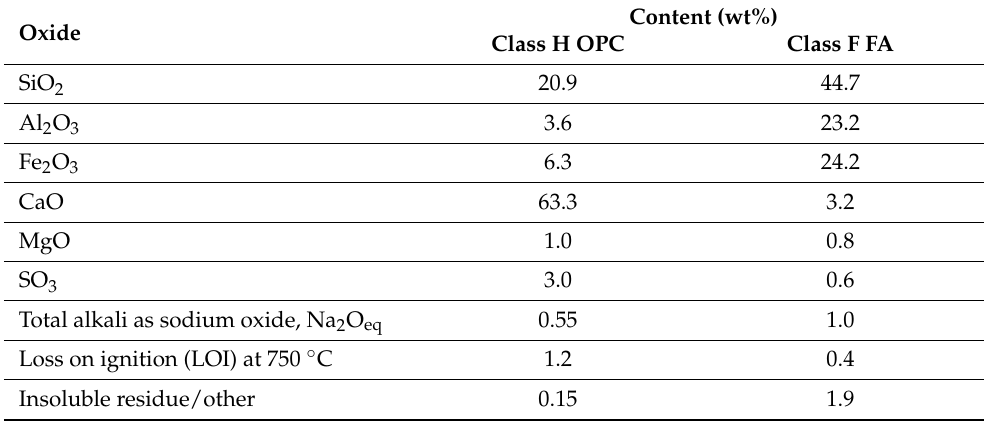
Table 1. Chemical compositions of Class H OPC and Class F FA used in this study.